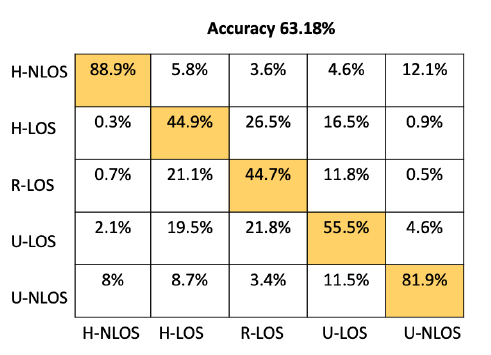
Figure 7. Confusion matrix for KNN based on LTS